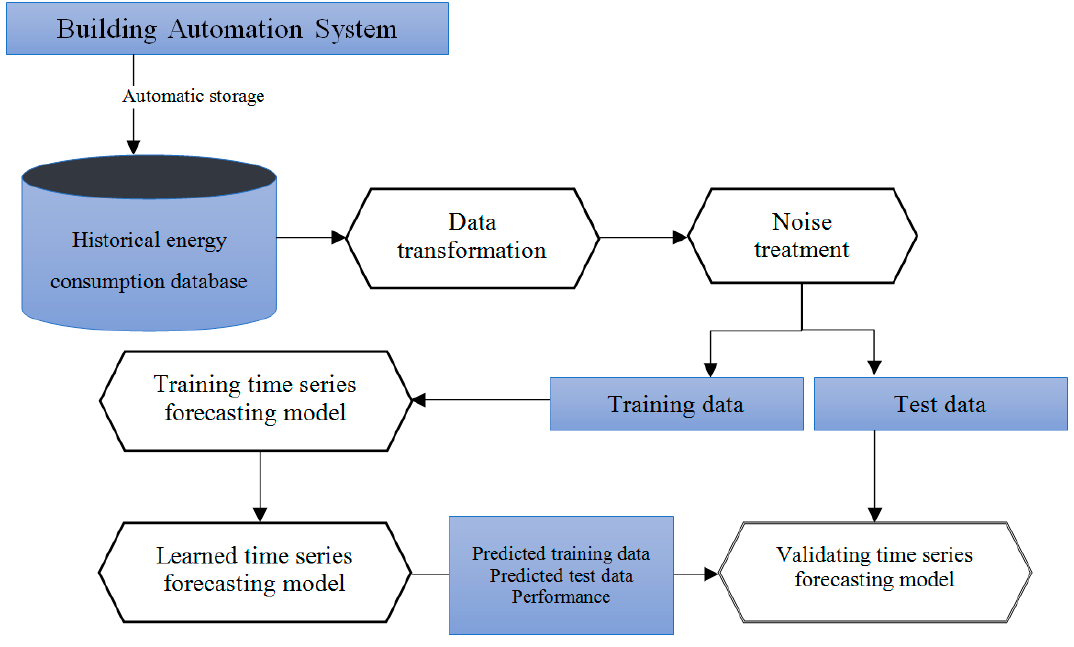
Figure 3. Flowchart of the energy time ‐ series model.